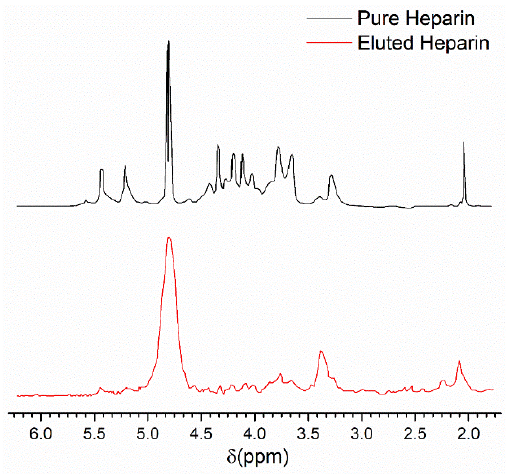
Figure 3. 1 H NMR spectra (400 MHz, D 2 O) of pure heparin (black) and real heparin (red), which is eluted and separated from QDASi.